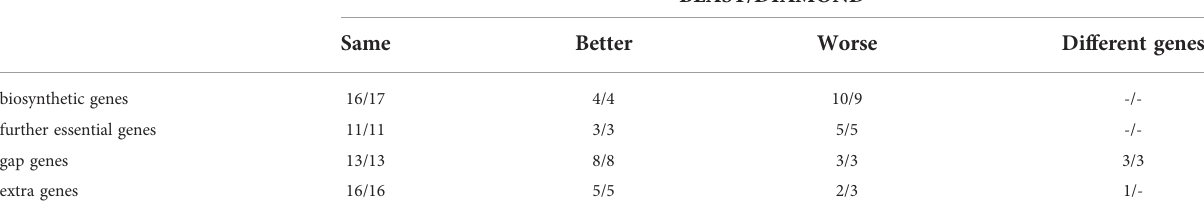
TABLE 2 Number of BGCs in which the automated cluster detection (in combination with BLAST or DIAMOND) delivered the same, better, worse, or different results for the given gene categories compared to the manual